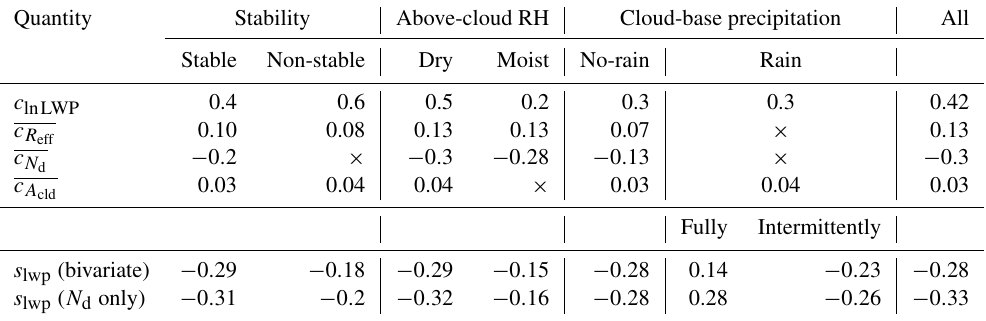
Table 1. This table summarises the regime dependence of each slope. The relationship between cloud properties and H BL is determined loga- rithmically (ln (cid:57) ∼ c ln (cid:57) × ln H BL for (cid:57) = LWP) or as normalised linear slopes ( c (cid:57) = c (cid:57) /(cid:57) where (cid:57) ∼ c (cid:57) × H BL for (cid:57) ∈ { R eff ,N d ,A cld } and (cid:57) denotes the average). Slopes were determined by linear regression if and only if (i) a significant fit was obtained at the 95% confidence level and (ii) the fit explained at least 80% of the variance of the climatological relationship shown in Fig. 3. If no such fit is obtained, “ × ” is given. The regime dependence of s lwp , which is defined and discussed in Sect. 4, is summarised in the last two rows. Estimates for s lwp were either obtained by simple linear regression or by a bivariate fit taking the covariability between LWP, N d , and H BL into account. All slopes are given to the significant digit, which is determined based on the error of the respective fit. Error statistics and sample sizes for each category are provided in Table S1 in the Supplement. Quantity Stability Above-cloud RH Cloud-base precipitation All Stable Non-stable Dry Moist No-rain Rain c lnLWP 0.4 0.6 0.5 0.2 0.3 0.3 0.42 c R 0.10 × eff − 0 . 2 × − 0 . 3 − 0 . 13 × − 0 . 3 c N d c A 0.03 0.04 0.04 × cld Fully Intermittently s lwp (bivariate) − 0 . 29 − 0 . 18 − 0 . 29 s lwp ( N d only) − 0 . 31 − 0 .